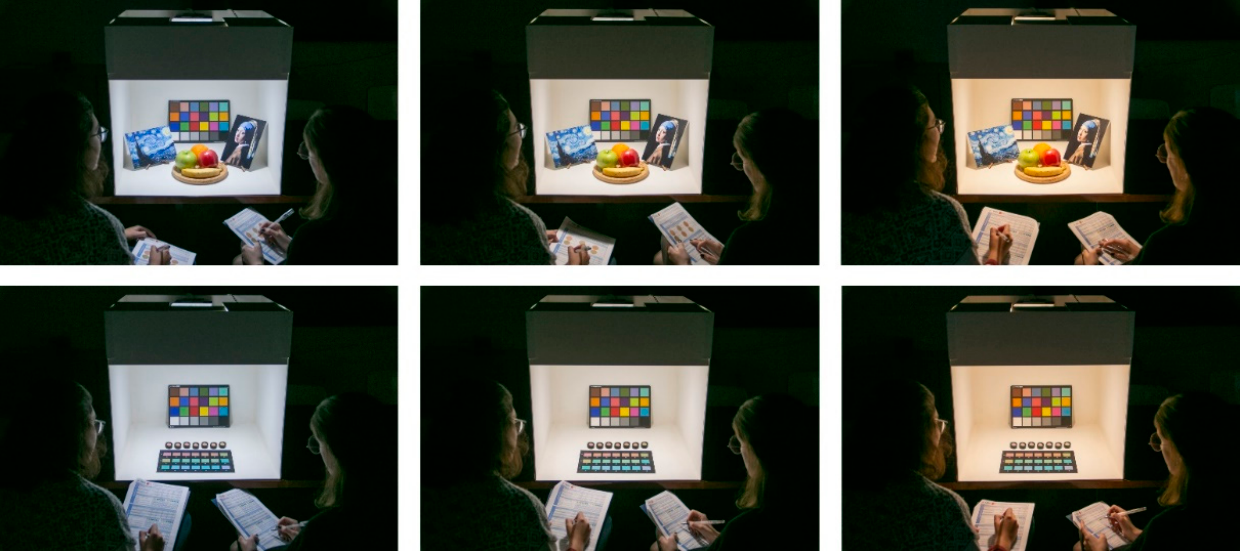
Figure 2. Analysis of color rendering of a cool, neutral and warm LED lamp in the light source testing box. Upper line: Objects used for the scenarios of trial 1: Two paintings and fruits; lower line: FM-test samples and color checker.